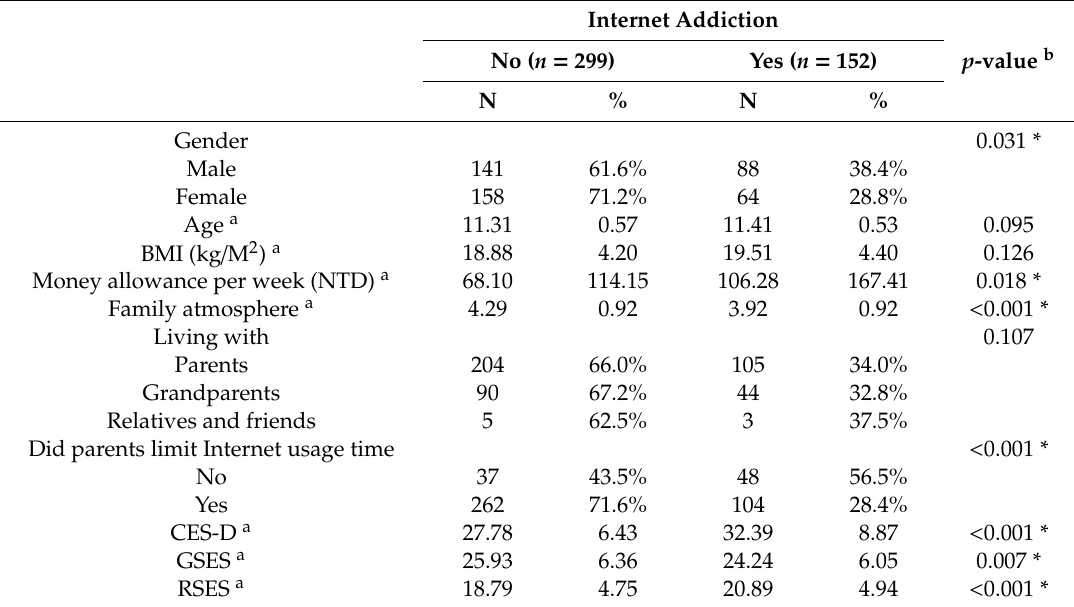
Table 2. Associations of demographics, family functionality, depression, self-e ffi cacy and self-esteem with IAT ( n =